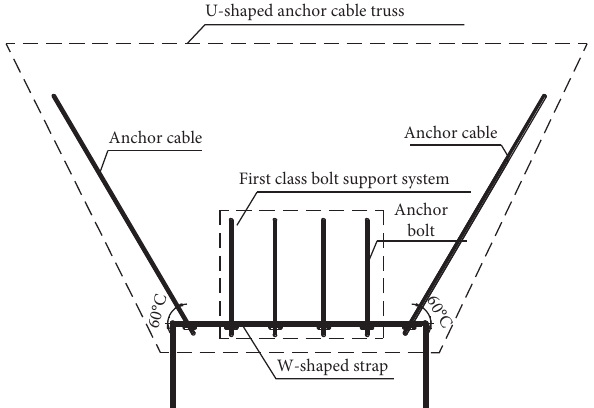
Figure 10: U-shaped anchor cable combined